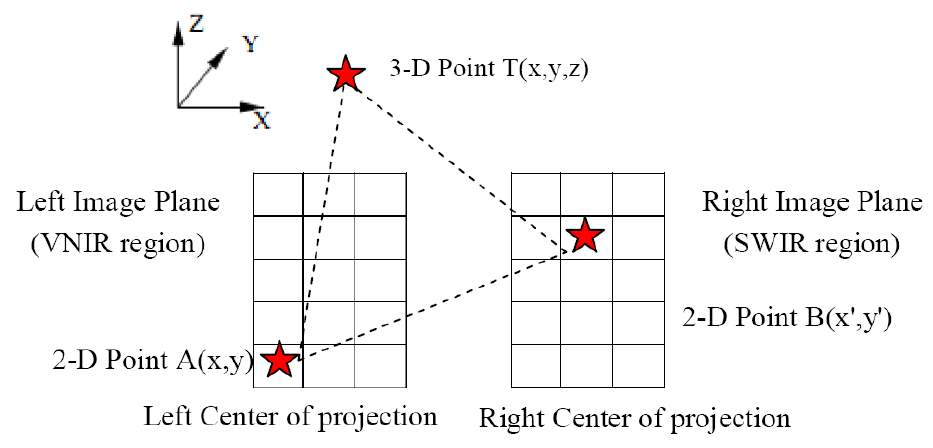
Figure 8. Projection of 3-D scene points on the image (in VNIR and SWIR regions)